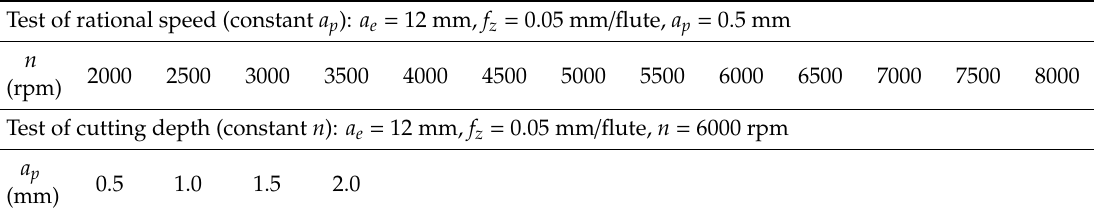
Table 1. Range of parameters used in experimental tests.